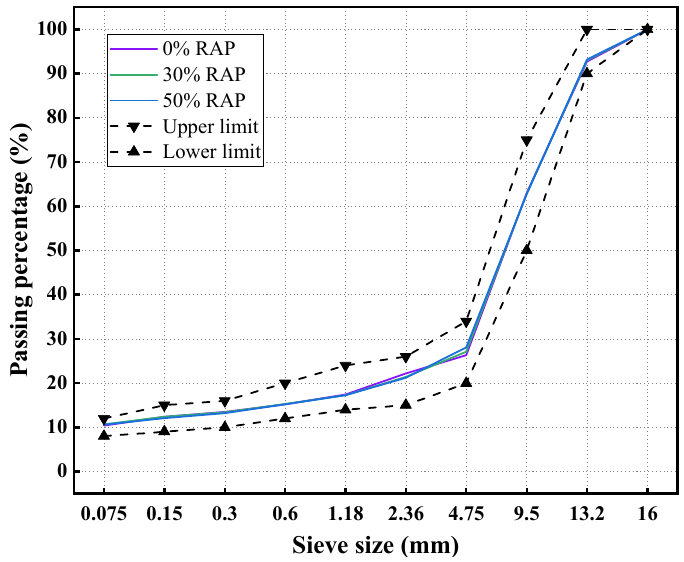
Figure 3. Combined gradations of reclaimed asphalt mixtures.